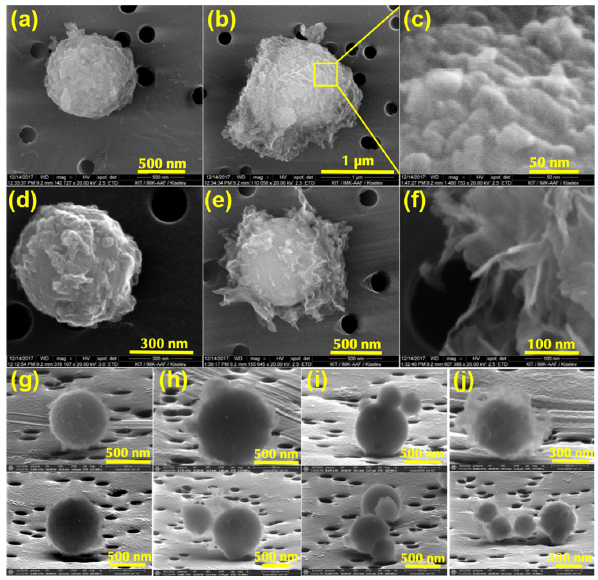
Figure 1. Scanning electron microscopy (SEM) images of CFA_UK (a) – (f) , CFA_Cy (g) , CFA_Mi (h) , CFA_Ja (i) , and CFA_Wh (j) particles. All particles have a basic spherical shape, which is common to coal fly ash particles: (a) spherical shape of CFA_UK with surface defects; (b) meshy or spongy material on the particle surface which looks highly porous; (c) a high-magnification image ( ∼ 50nm) of the pores or surface defects on the CFA_UK aerosol particles; (d) the core of CFA_UK shows a spherical shape like image (a) with scaly materials on the surface; (e) despite the flake-like network materials on the surface of the CFA particles – the basic spherical core is still intact; (f) high magnification of the flaky, meshy material on the particle surface; (g) CFA_Cy particles also show some degree of deposits on the surface; (h) CFA_Mi with light meshy material compared with CFA_UK; (i) CFA_Ja particles with a non-smooth surface; and (j) CFA_Wh particles with a denser flaky network material on the surface than the other USA CFA sam- ples. Images of the USA CFA particles taken by Garimella (2016) also showed scaly materials on the surface of the particles. How- ever, CFA_UK particles had more defects and materials on the sur- face which were very irregularly